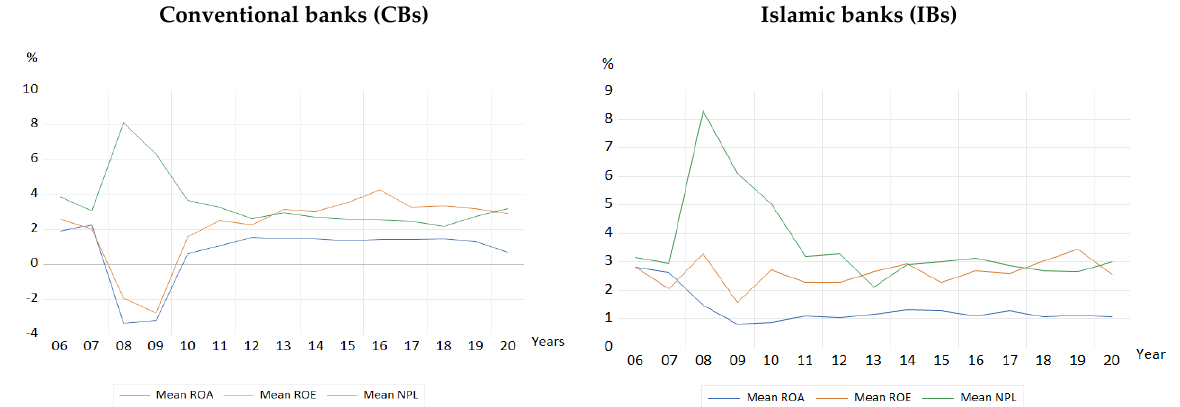
Figure 2. Evolution of average ROA, ROE, and NPL over 2006–2020 (%).